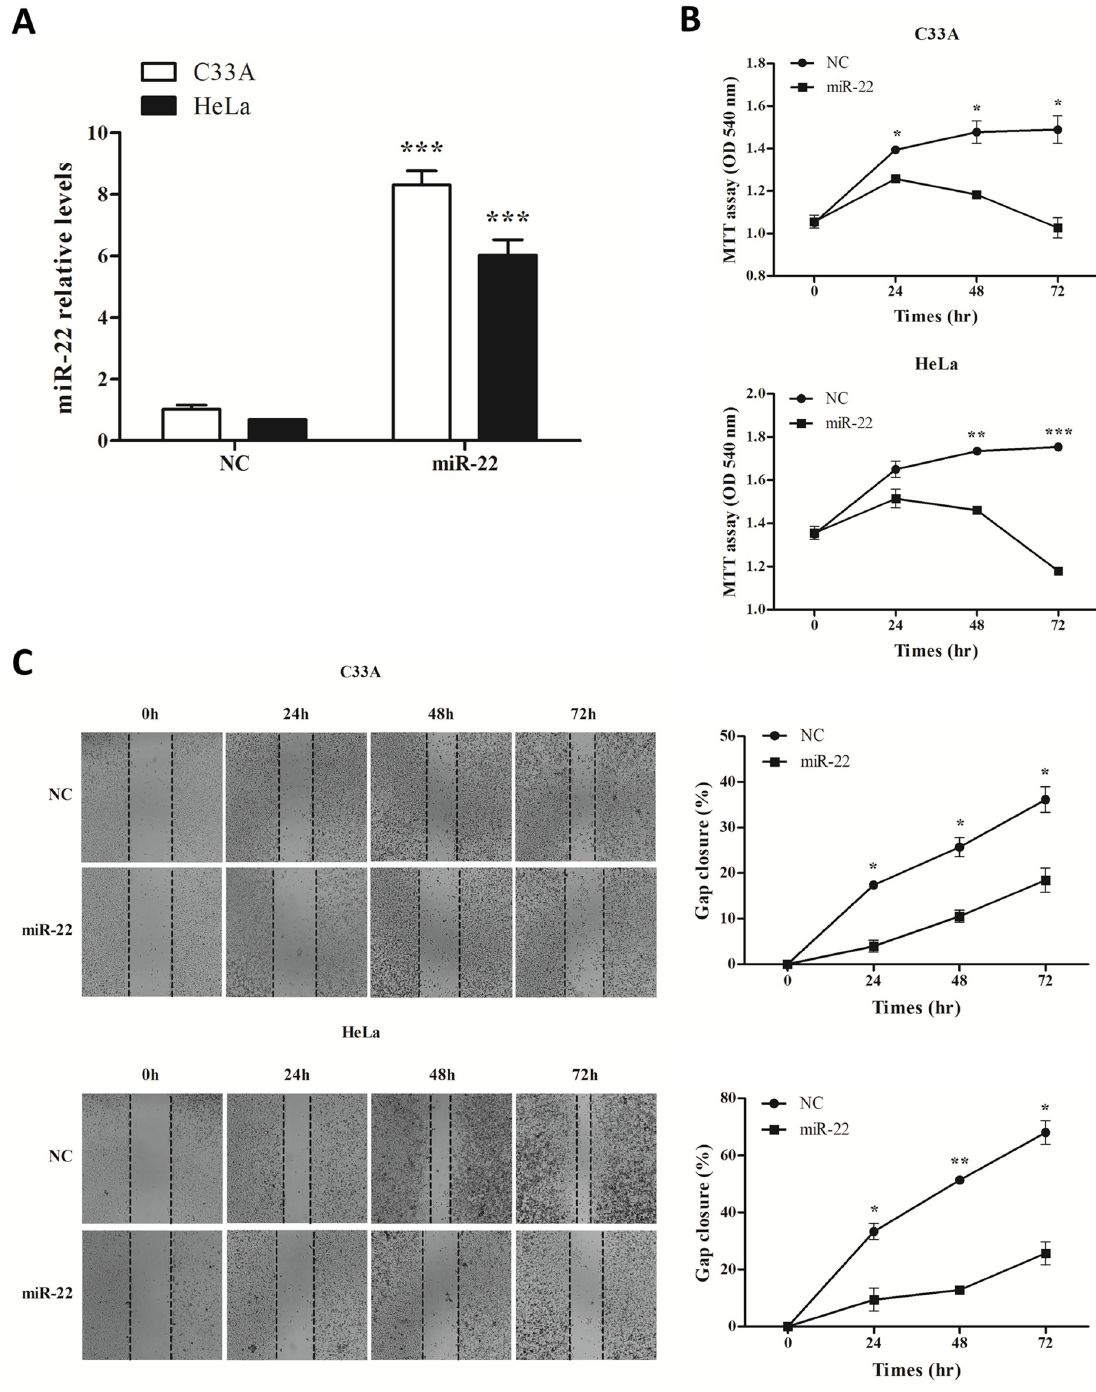
Fig 5. Overexpression of miR-22 inhibited proliferation and migration of cervical cancer cell lines. A. Transfection of miR-22 expression plasmid to C33A and HeLa cells increased the expression of miR-22 detected by real-time quantitative RT-PCR. B. Cell proliferation of these cells transfected as in (A) was measured at the indicated time periods using the MTT assay. C. Overexpression of miR-22 led to a slower closing of scratch wounds, compared with negative control transfected cells. Error bars indicate the standard error of the mean (SEM) of triplicated independent experiments. � P < 0.05, �� P < 0.01, ��� P < 0.001.